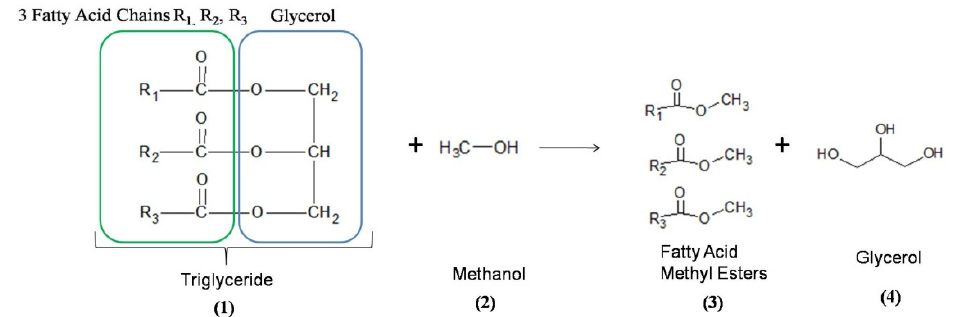
Figure 1. Production of glycerol from the transesterification of adapted triglycerides [2].